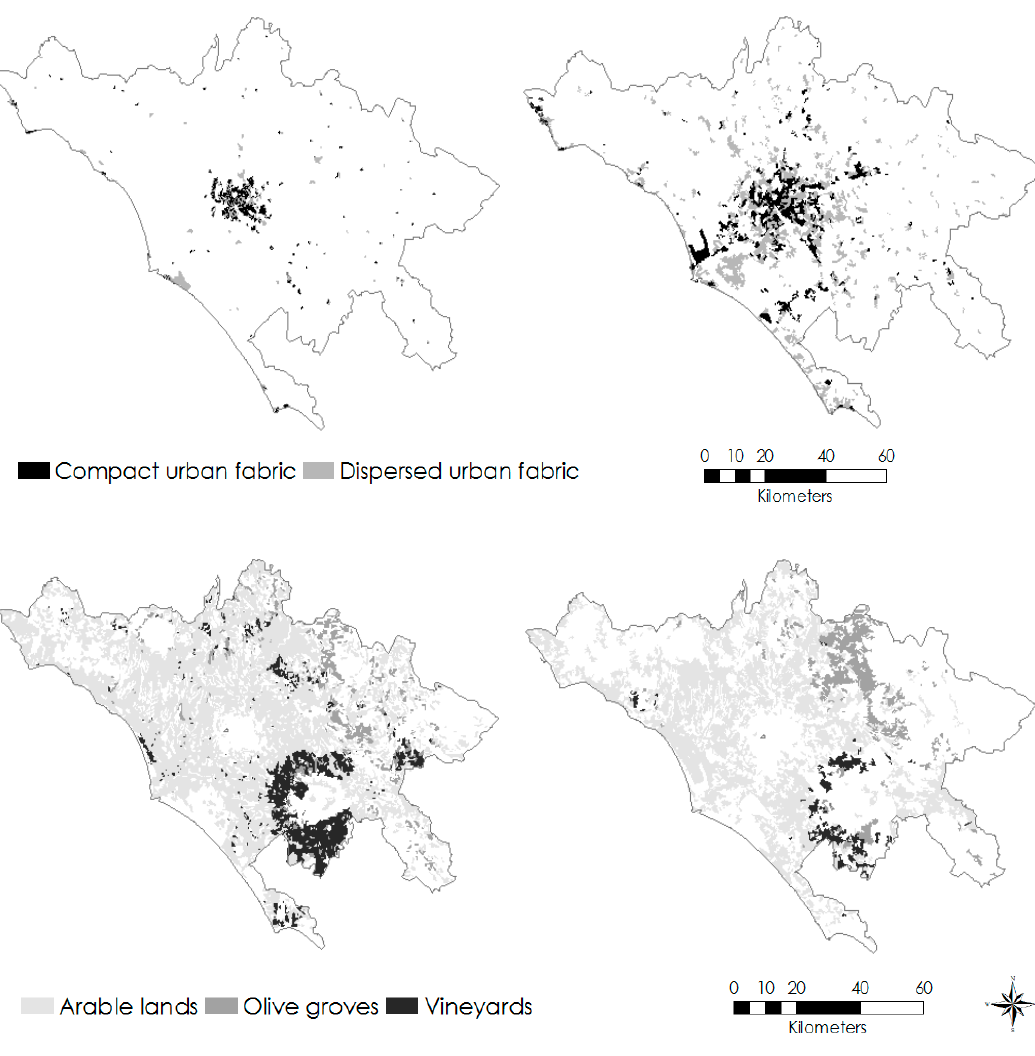
Figure 7. Long-term land-use changes in the study area ( left : 1960; right : 2018).